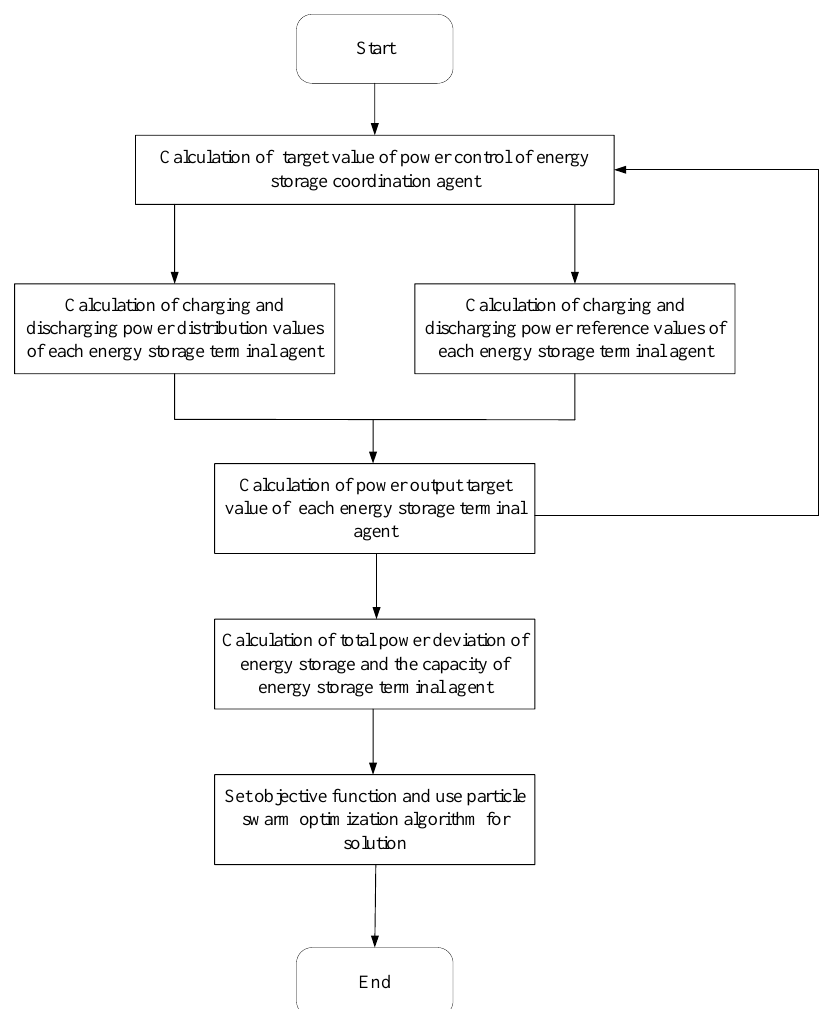
Figure 8. Multi-energy storage agent cooperative control algorithm.